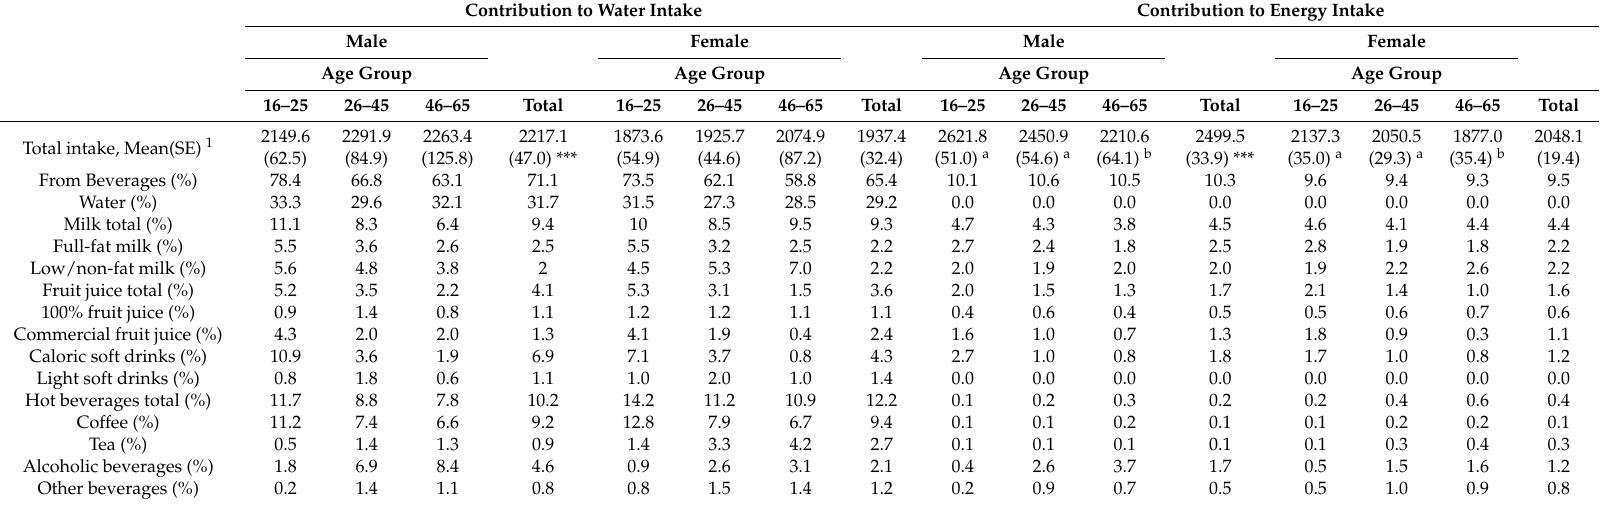
Table 4. Contribution of beverages to total water and energy intake by gender and age